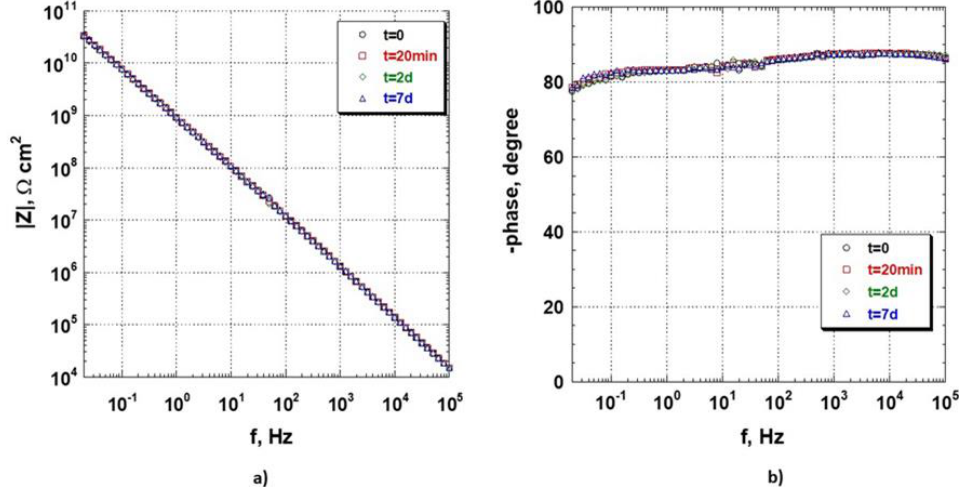
Figure 8. ( a ) Impedance modulus |Z|; ( b ) phase angle plots of CNR sample immersed in an aerated 3.5 wt.% NaCl solution for 7 days.